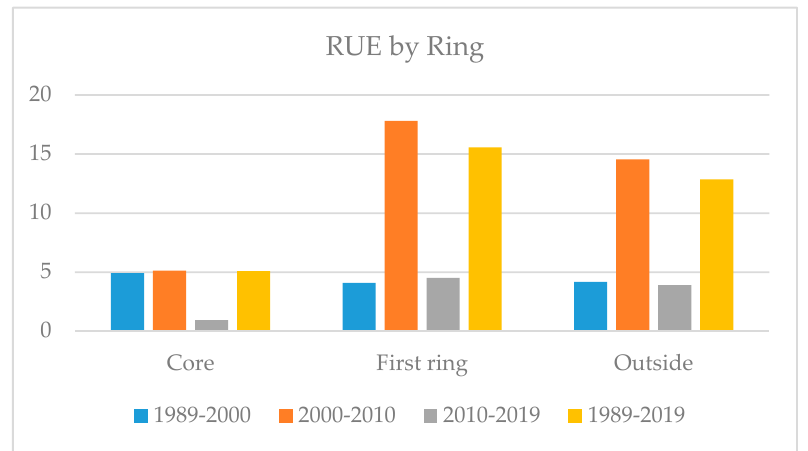
Figure 11. RUE values by ring between 1989 and 2019.